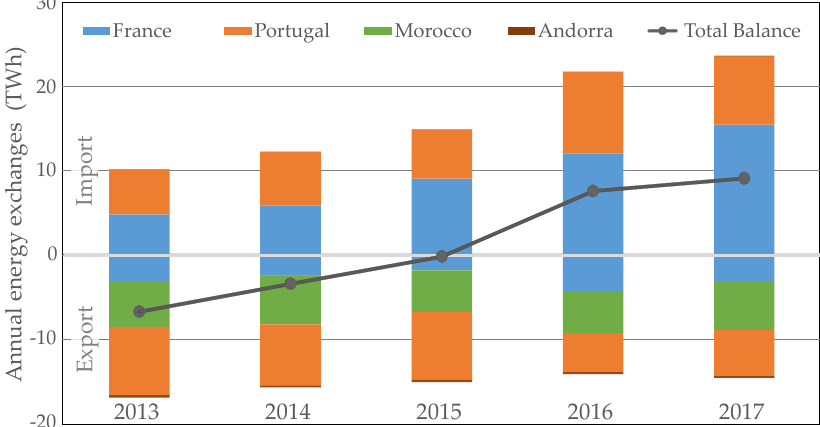
Figure 3. Evolution of the annual international energy exchanges of the Spanish peninsular system.